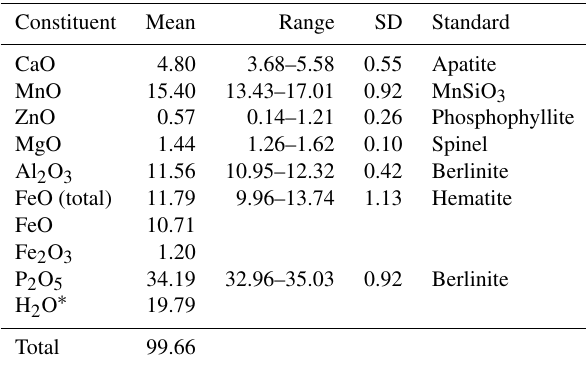
Table 1. Analytical data (wt%) for